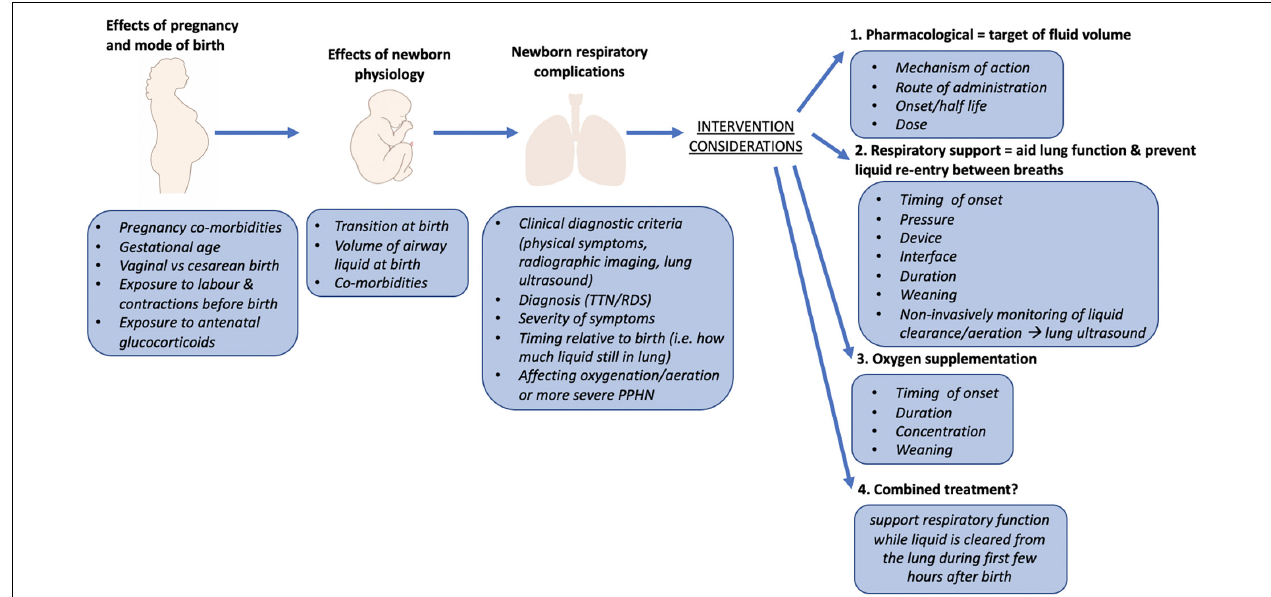
FIGURE 2 | Overview of factors that influence the risk of respiratory distress in term newborns (>37 weeks gestation). Includes contributing factors during pregnancy, birth, and during the transition from fetal to newborn life. Consideration should be given to the physiology underpinning the newborn respiratory complications and the mechanisms underlying treatments that are provided to newborns to most successfully manage the respiratory distress symptoms. TTN, transient tachypnea of the newborn; RDS, respiratory distress syndrome; PPHN, persistent pulmonary hypertension of the